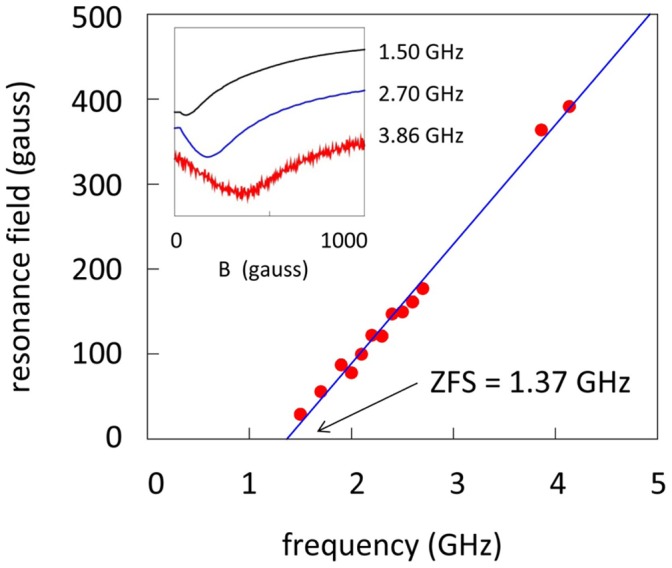
Frequency-dependent EPR signal assigned to S = 1 Ni(0) in male SMA connectors.The minimum of the broad signal (determined as the zero crossing of the derivative) was followed with frequency decreasing in 0.1 GHz steps until disappearance in zero field. Two points around 4 GHz were obtained with an S-band bridge as source and power-meter detection; two points at 9.1 and 10.0 GHz obtained with an X-band bridge (not shown) were also on the straight-line fit that extrapolates to a zero-field splitting of 1.37 GHz or 0.0457 cm−1.